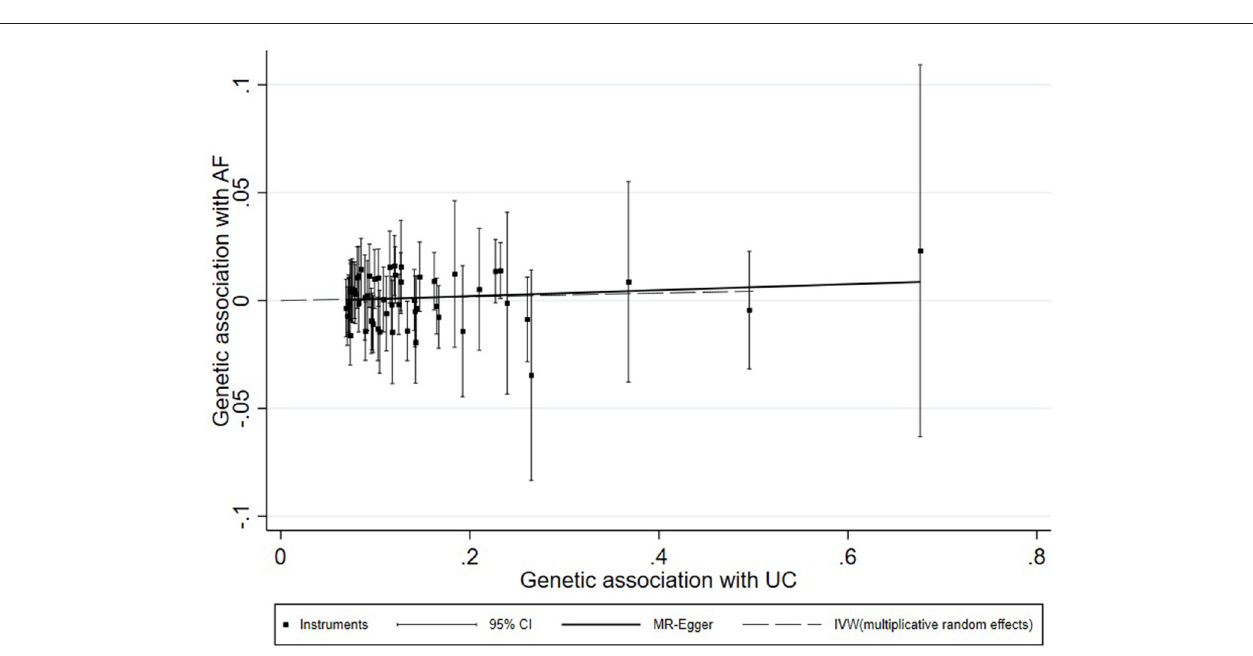
FIGURE 4 | Scatterplot of genetic associations with atrial fibrillation against associations with ulcerative colitis, with causal estimates ( β coefficients) of ulcerative colitis on atrial fibrillation estimated by weighted inverse-variance (dashed line), and MR-Egger (solid line) methods. The straight lines should be the change in the log odds of atrial fibrillation per unit increase of the log odds of ulcerative